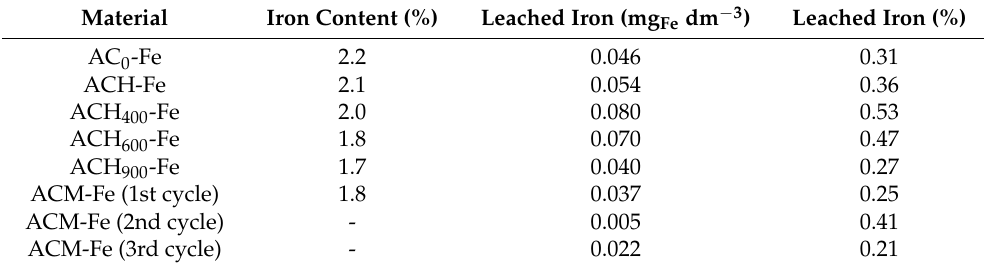
Table 5. Iron content and amount of iron leached in heterogeneous Fenton oxidation with different catalysts.